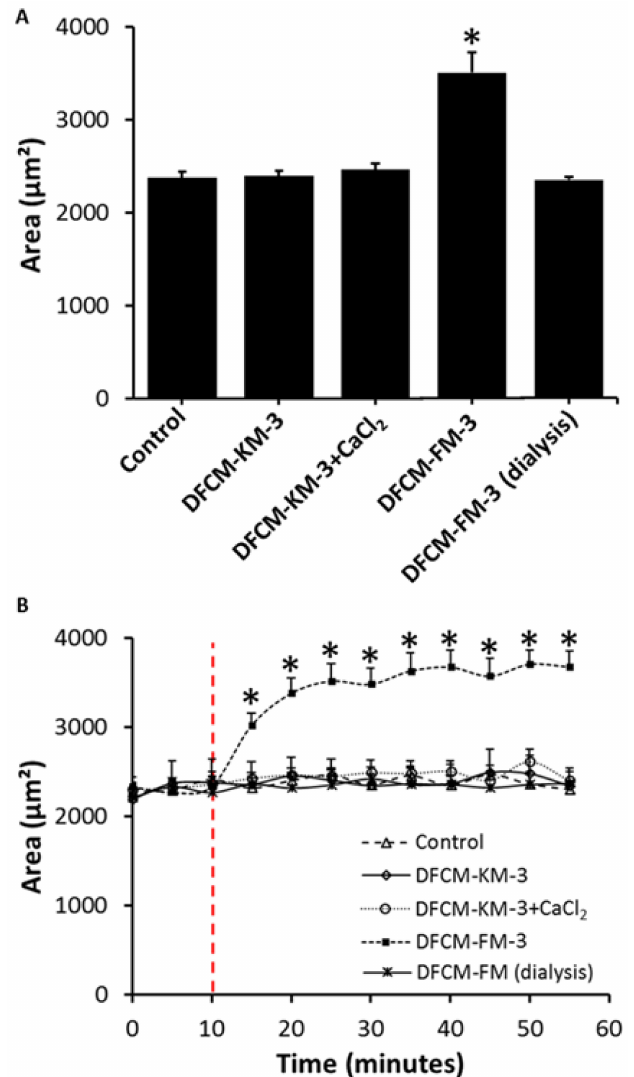
Figure 4. Effect of calcium in DFCM on keratinocyte area. ( A ) Keratinocyte area detected 24 h after supplementation with DFCM-KM − 3, DFCM-FM − 3, DFCM-KM − 3-CaCl 2 , or DFCM-FM − 3 (dialysis) in compared to control. ( B ) Quantitative evaluation of keratinocyte area before and after supplementation with DFCM. Here, * indicates significantly higher compared to other conditions ( p ≤